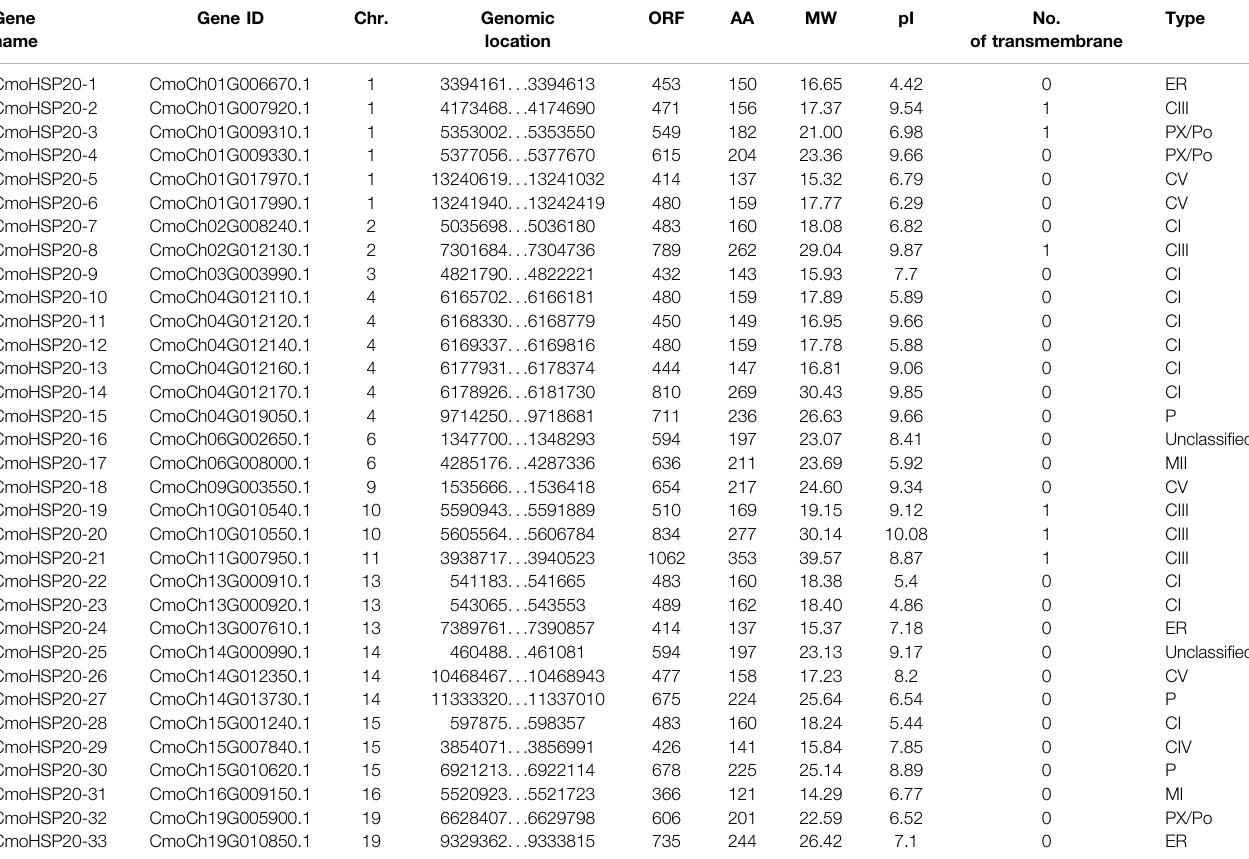
TABLE 1 | Features of CmoHSP20 genes in